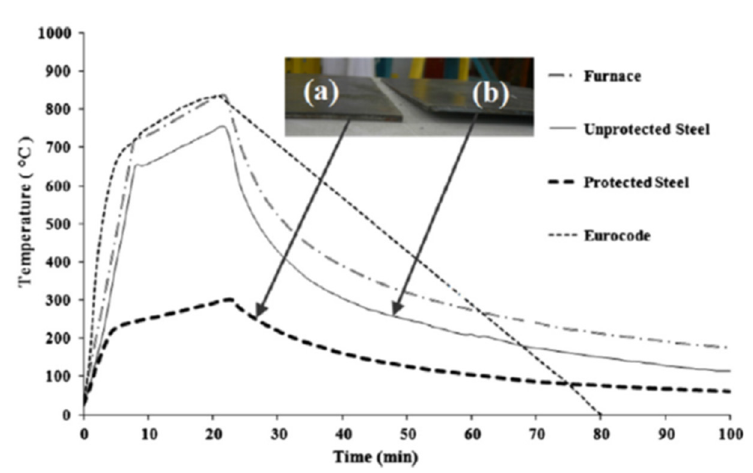
Figure 4. Time temperature curves for Eurocode, ( a ) protected and ( b ) unprotected steel plates [26].